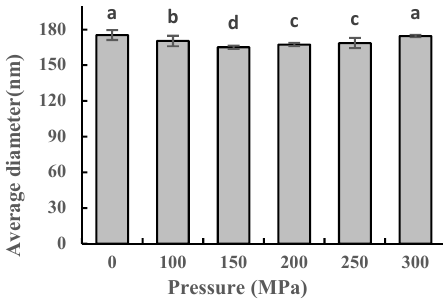
Figure 4. Average particle size of casein under different pressure conditions. Different superscript letters within a column indicate significant differences between means ( p < 0.05).